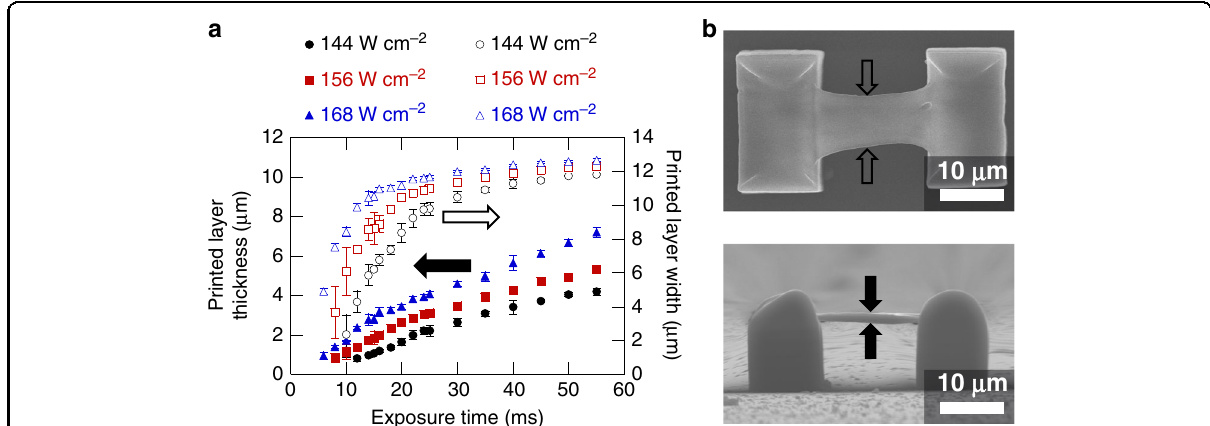
Fig. 3 Printing of single layers. a Printed layer thickness and width for varying exposure times and laser intensities. DMD pattern of 2.28 mm width was used for printing all layers. Each layer was printed suspended across two prefabricated supports. Error bars indicate one standard deviation of measurements. b Example scanning electron microscope (SEM) images of printed layer structure using 156 W cm − 2 intensity and 14 ms exposure viewed from top (upper image) and side (lower